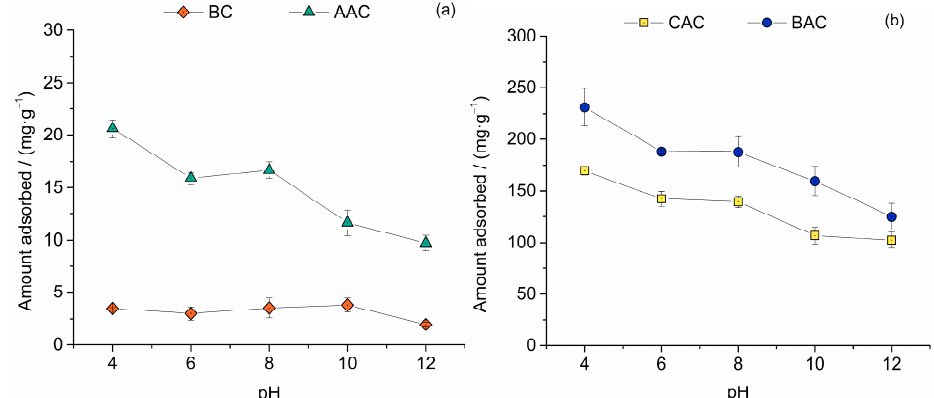
Figure 4. Isoniazid adsorption capacity according to solution pH for ( a ) BC and AAC and ( b ) CAC and BAC. Conditions: temperature of 25 °C, residence time of 60 min, ( a ) 4 g·L − 1 and ( b ) 1 g·L − 1 of adsorbent, and ( a ) 60 mg·L − 1 and ( b ) 200 mg·L − 1 of isoniazid concentration.